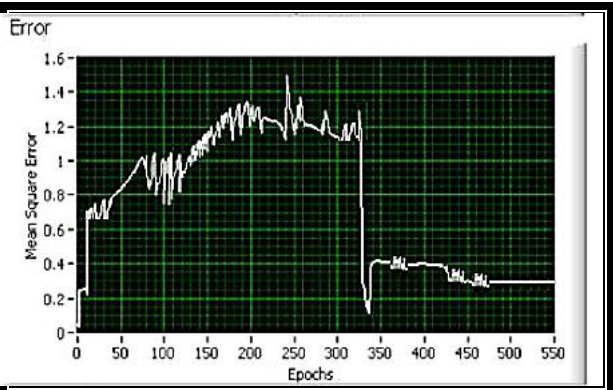
Fig. 9 . Optimization of proposed MISO ANFIS pressuriser pressure controller